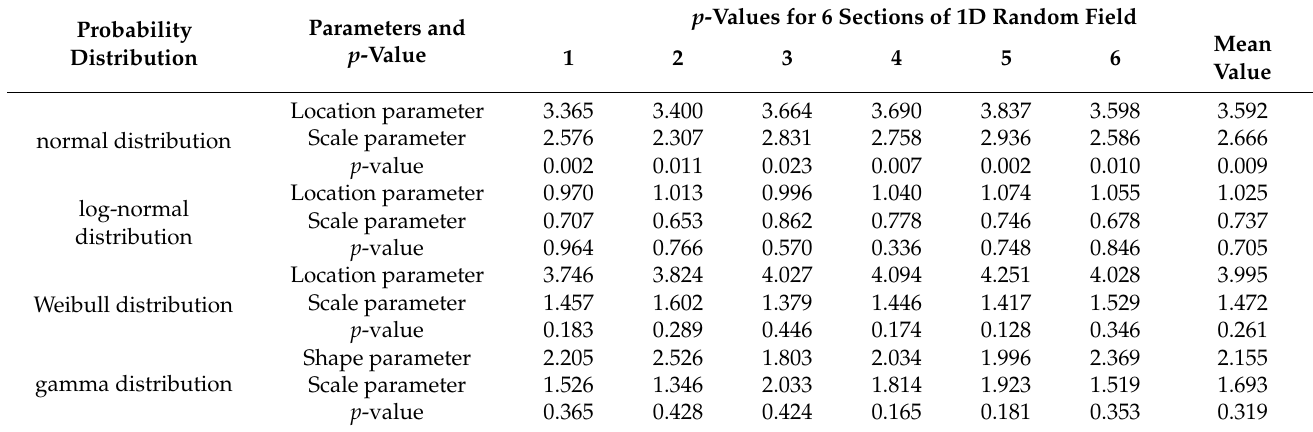
Table 1. Pointwise parameters estimation for the nano-hardness of the bulk paste.